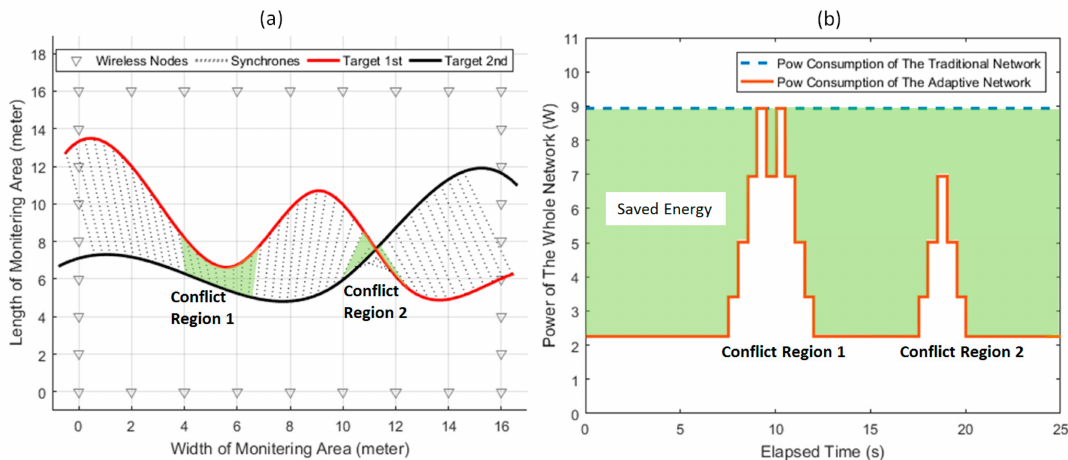
Figure 12. ( a ) A specific multitarget tracking scenario in the WSN. ( b ) The energy saving in the adaptive network, relative to the traditional